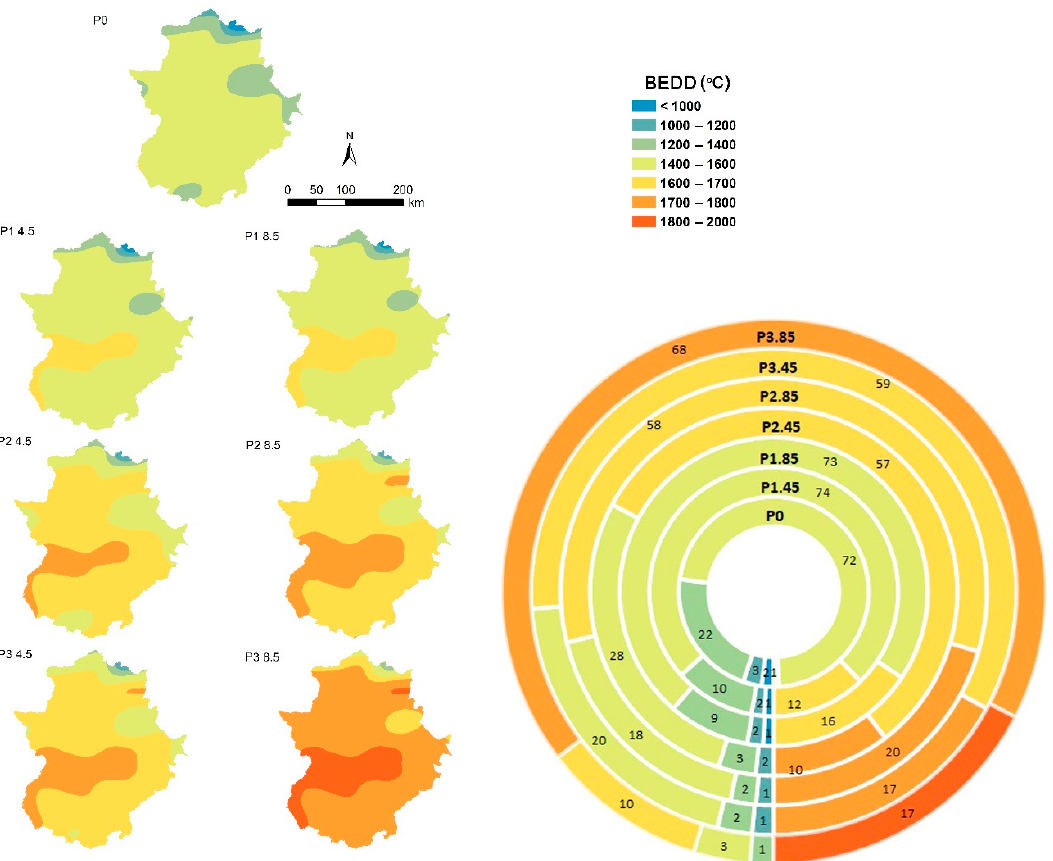
Figure 7. Spatial distributions of BEDD during the historical period (P0) and the future time periods (P1, P2 and P3) in Extremadura. The percentages of each BEDD class for all time periods and under both scenarios, RCP 4.5 and RCP 8.5, are also shown (for instance, P1.45 means the time period P1 under the scenario RCP 4.5).